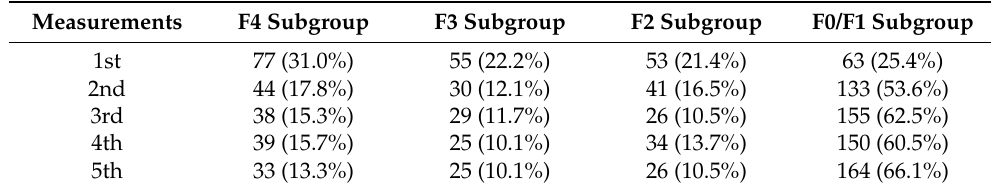
Figure 9. Graphic description of the distribution of patients in subgroups according to changes in the fibrotic stage throughout the follow-up period.